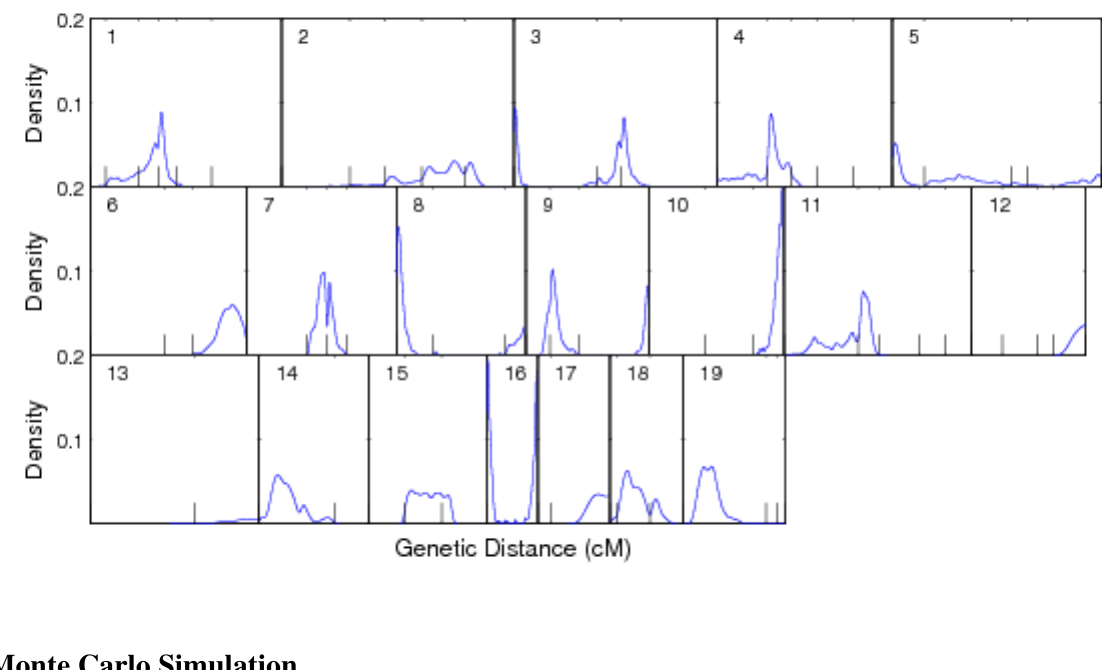
Figure 1. A profile of Estimated marginal posterior distribution of the QTL location by assuming that exactly one QTL is located on one of the chromosome